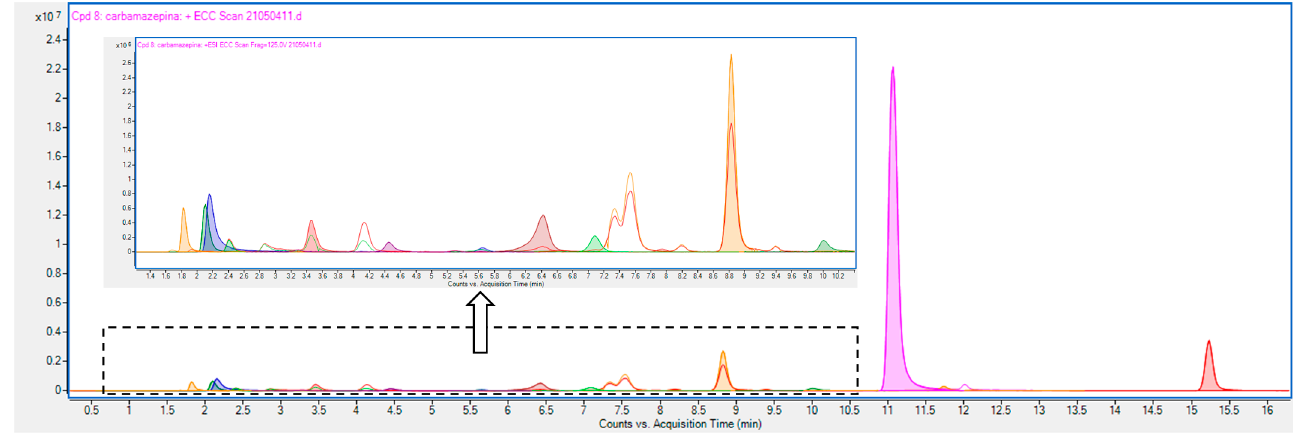
Figure 11. Chromatographic profile of the major compounds detected in the sample of carbamazepine oxidized to pH = 5.0. Experimental conditions: (CBZ) = 50.0 mg/L; (Fe) = 10 mg/L; (H 2 O 2 ) = 15.0 mM; T = 25 °C; (UV) = 150 W.